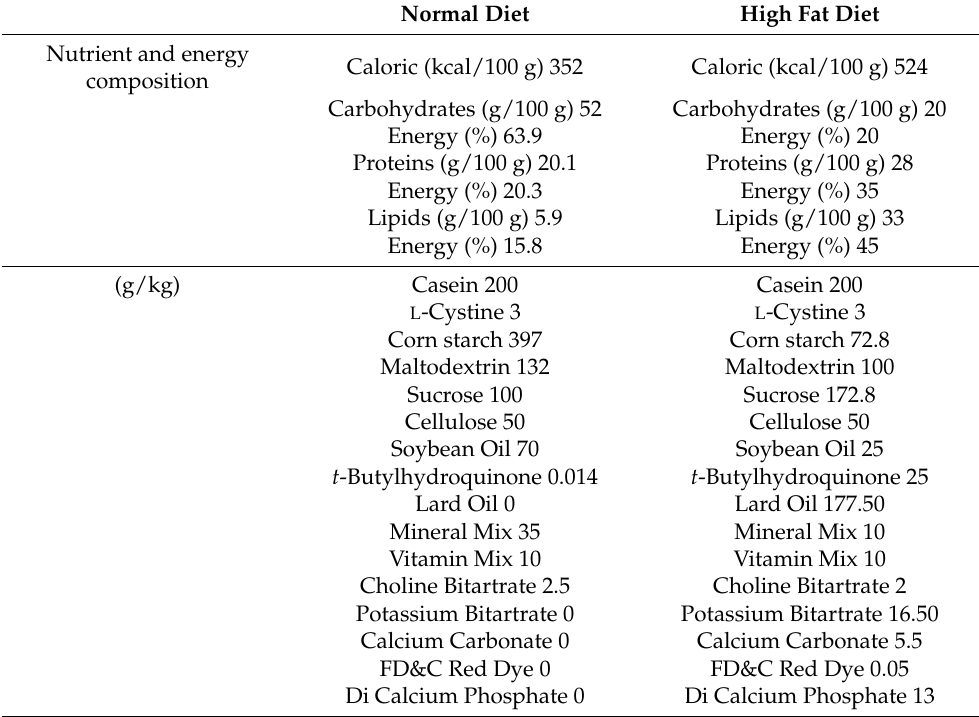
Table 1. Composition of normal and high-fat